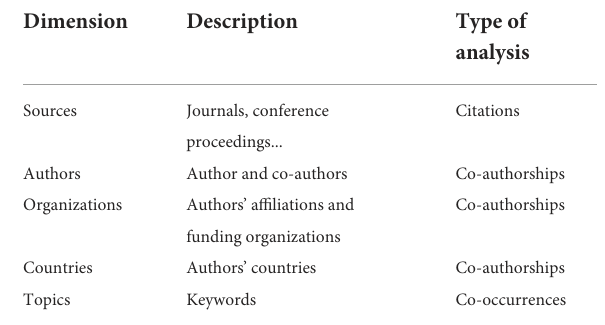
TABLE 2 Dimensions of analysis, meaning, and type of analysis available for